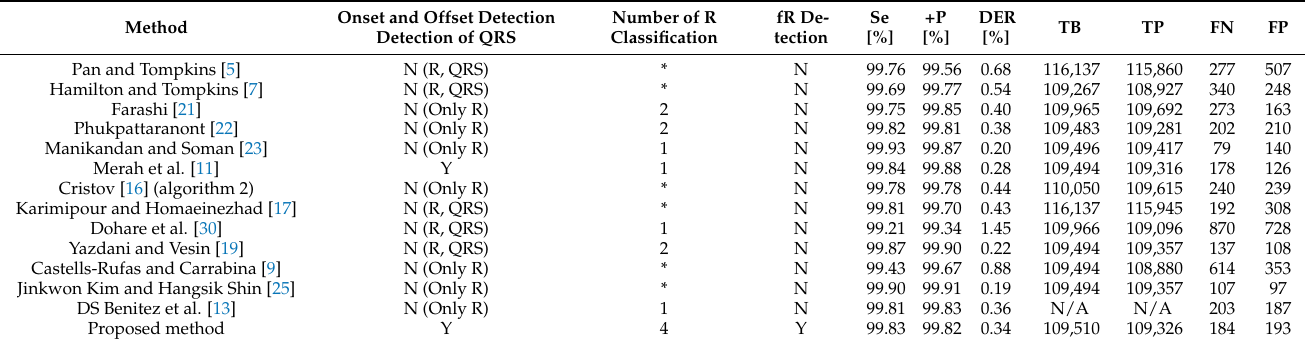
Table 4. Comparison of R-peak detection performance and supplemental function for several methods. Method Onset and Offset Detection Detection of